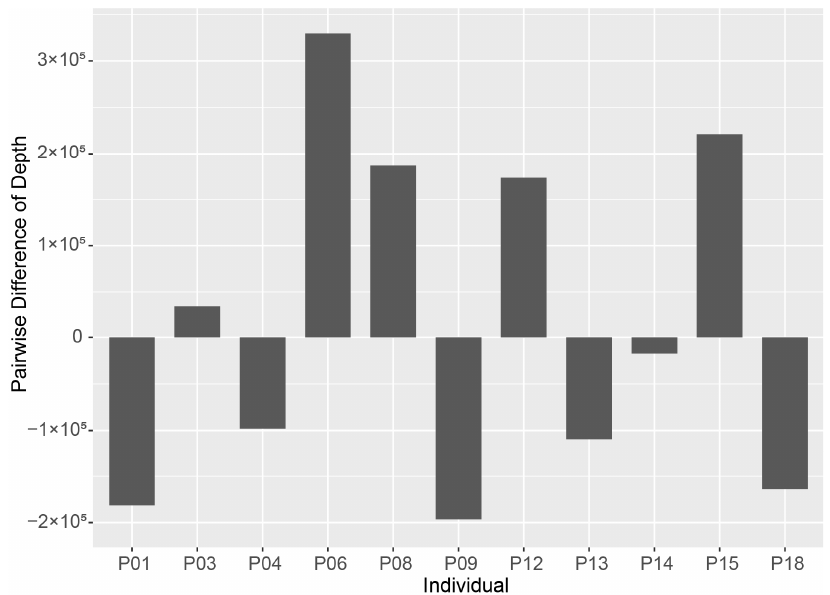
Figure 4. The pairwise differences in total depth between blood sample and hair shaft of the same individual. Total pairwise depth difference: the total depth of the hair shaft minus the total depth of the corresponding blood sample.